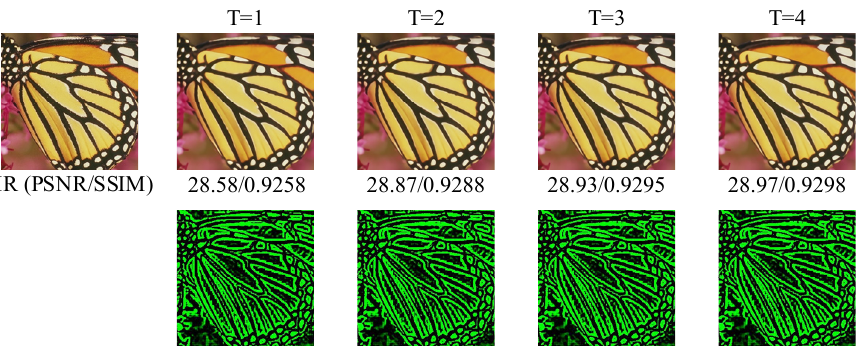
Figure 7. In the test of the best model of BI × 4, the first group indicates that the reconstruction performance improves with the increase in T. The second group is its corresponding residual map I T Res